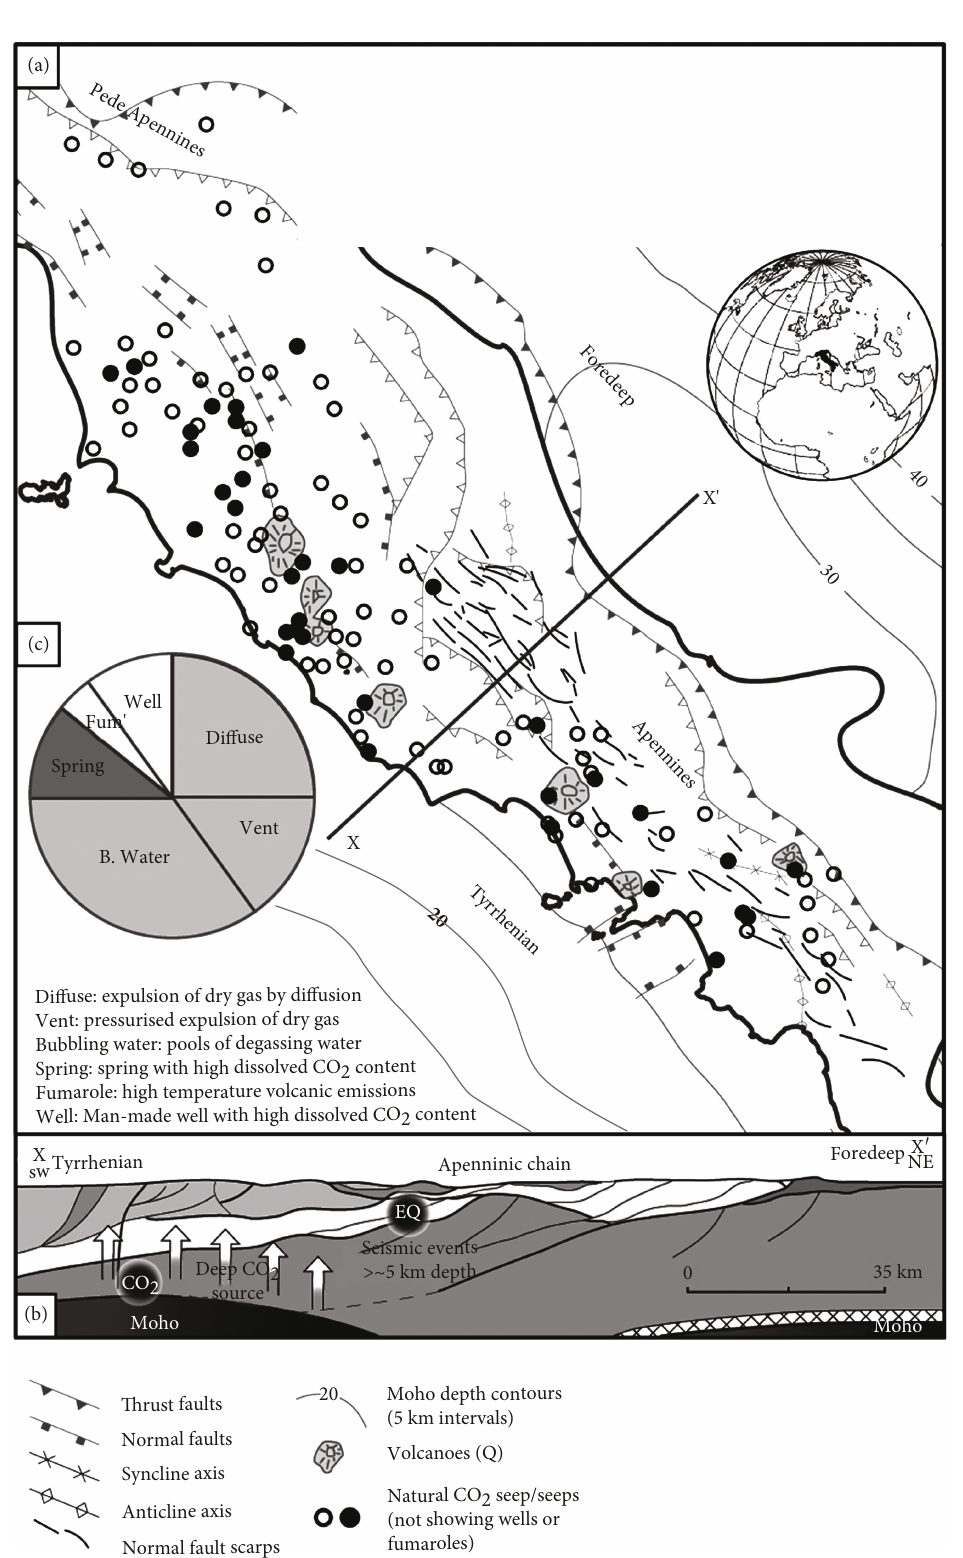
Figure 1: Schematic map of Italy showing the location of regional geological structures and Quaternary (Q) volcanoes (adapted from [25, seeps [10] (where fi lled symbols indicate multiple seeps), Moho depth contours [27], and mapped normal fault scarps after [28]. 26]), CO 2 Filled symbols show multiple seeps. Location of Italy shown on the globe inset. (b) Crustal cross-section of the Central Apennines modi fi ed from [17, 29, 30]. While earthquakes (EQ) and CO delivery occur across the section, circles indicate the main, simpli fi ed 2 occurrences. (c) Proportion of CO seep types classi fi ed qualitatively according to surface 2